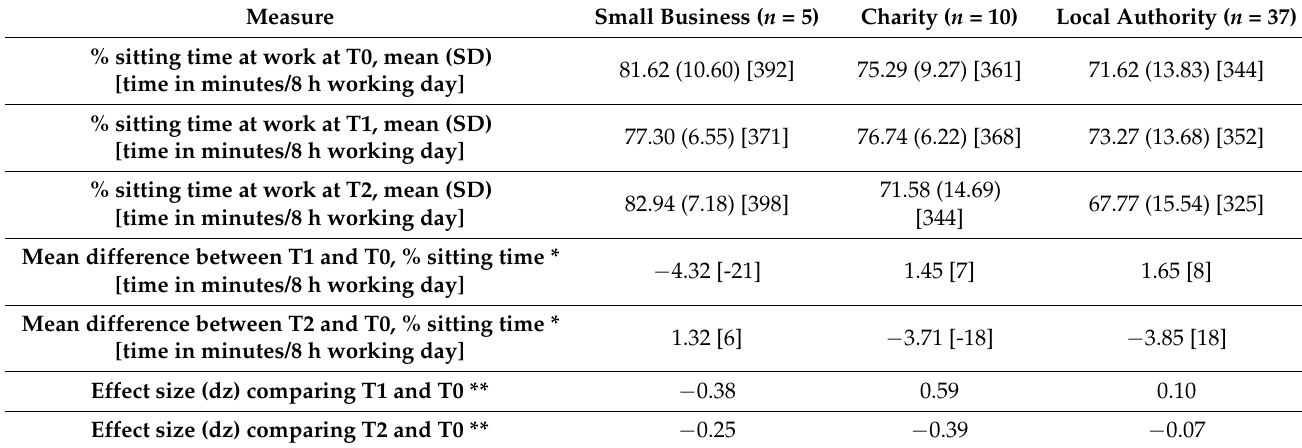
Table 3. Objective sitting time at T0, T1 and T2 from activPAL3™